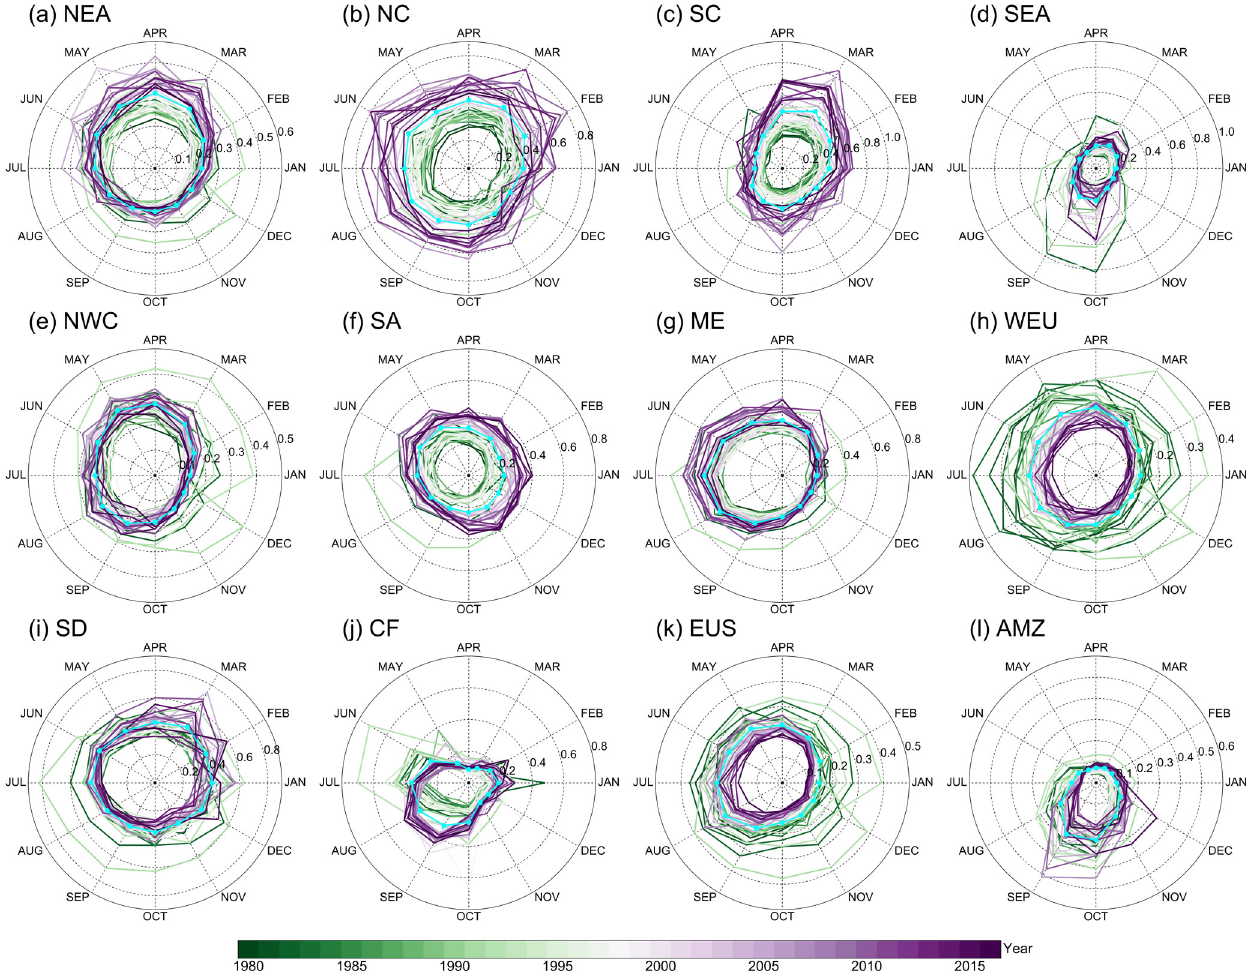
Figure 5. Temporal evolution of regional monthly averaged AOD for the 12 regions of interest. Each year is represented by an irregular ring with 12 directions. Each direction of the ring represents a specific month, the distance from the center of the ring represents the regional monthly mean AOD value and the color of the ring represents the year. A special cyan-colored ring represents the monthly mean AOD for the period